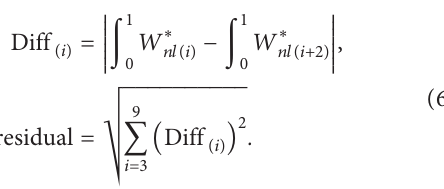
Table 5: The convergence test of the normalized first nonlinear modes with different numbers of basic functions in the forced vibration case. F